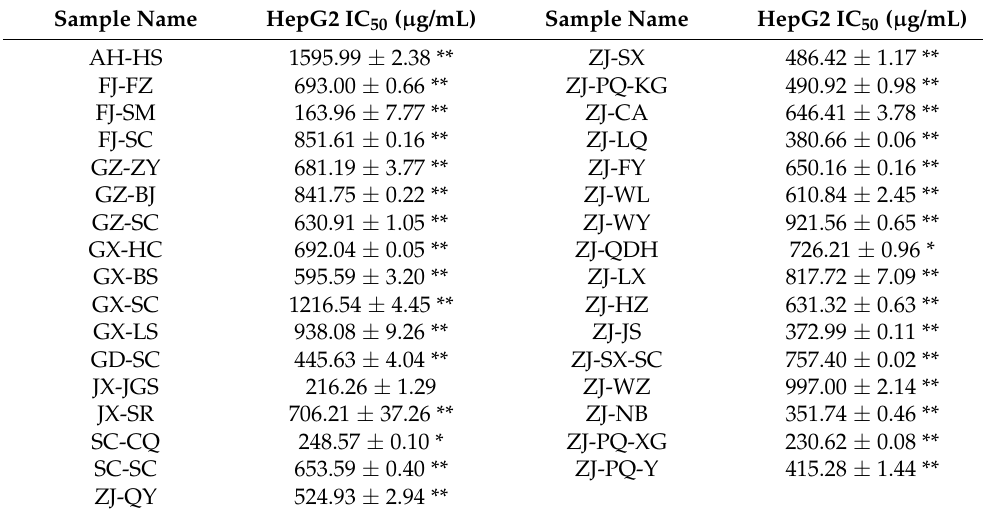
Table 3. IC 50 of growth inhibition of HuH-7 tumor cells by T. hemsleyanum of different origins ( n = 3, * p < 0.05, ** p <